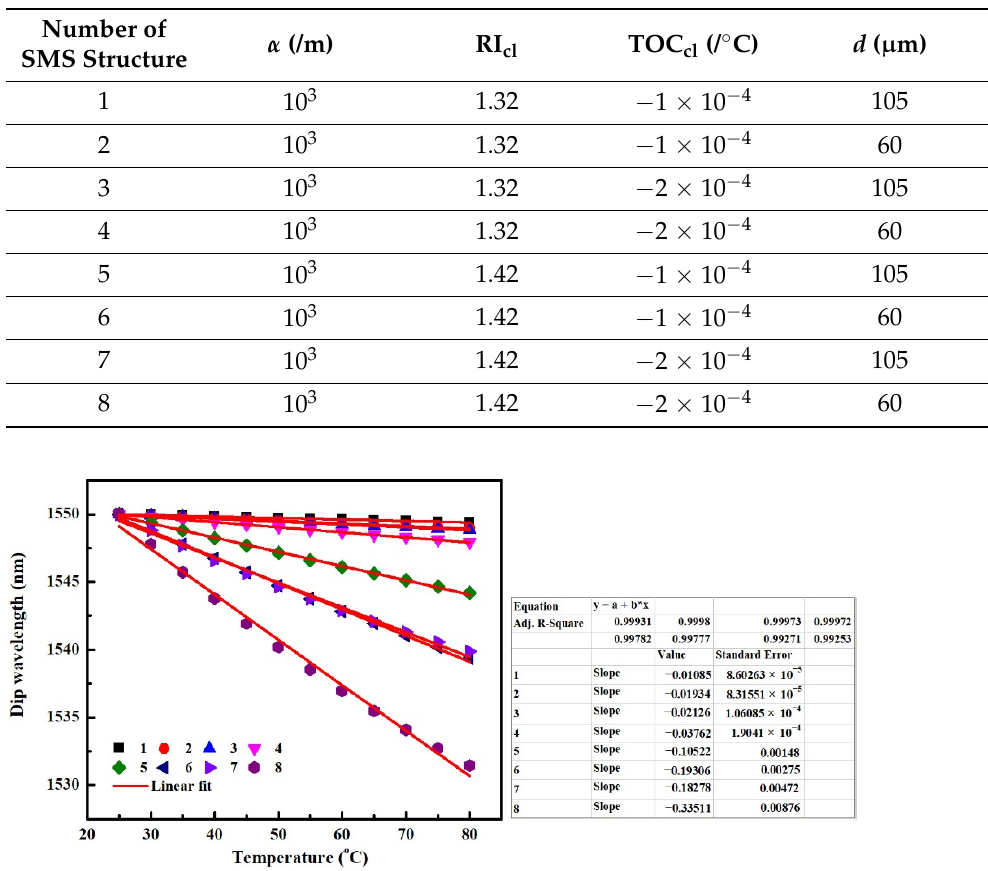
Table 1. Parameters of MMF in the SMS fiber structure.